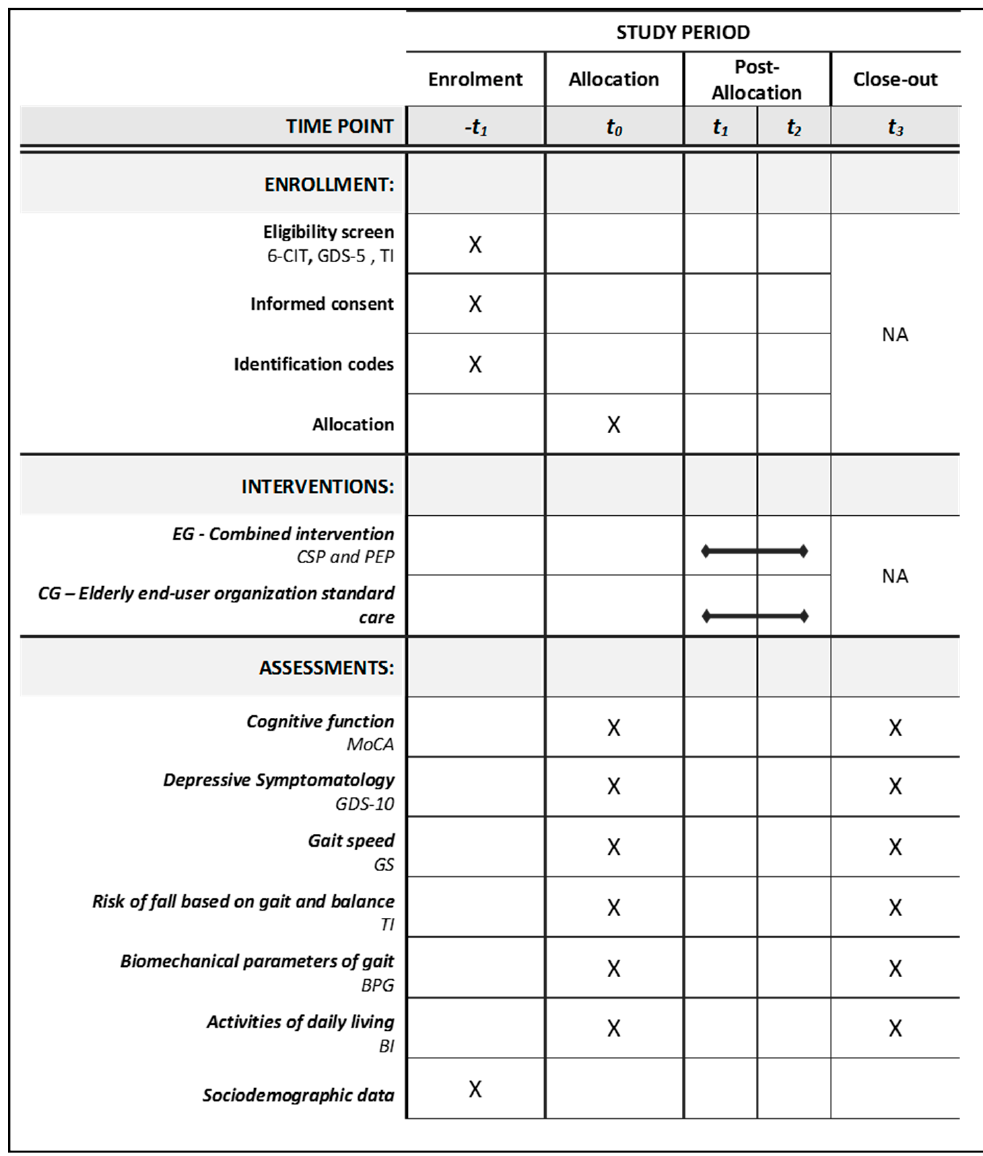
Figure 2. Schedule of enrollment, interventions and assessments based on SPIRIT 2013 Statement.